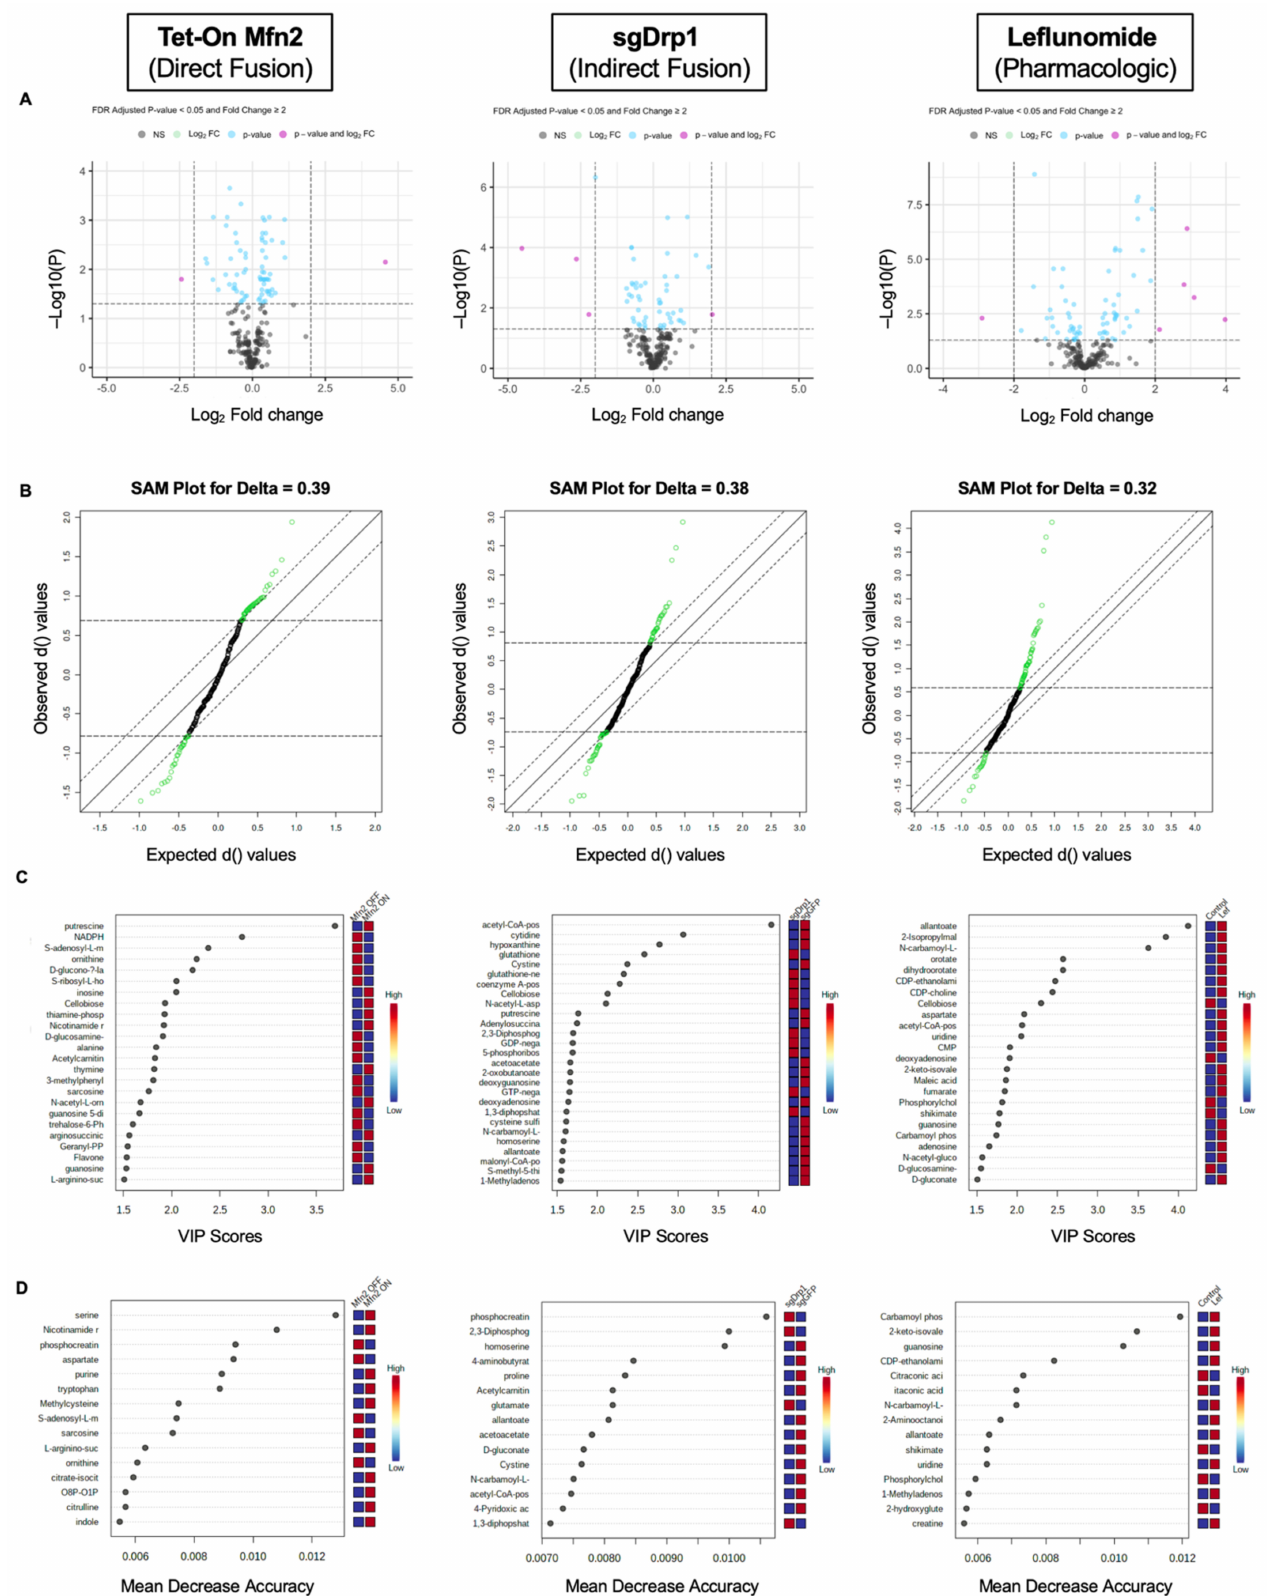
Figure 5. Statistical methods to identify differentially expressed metabolites after inducing mitochondrial fusion. ( A ) uni- variate Student’s t -test, FDR-adjusted p -value < 0.05, ( B ) SAM, FDR < 0.05, ( C ) PLS-DA, VIP score < 1.0, ( D ) RF model, Mean Decrease Accuracy >